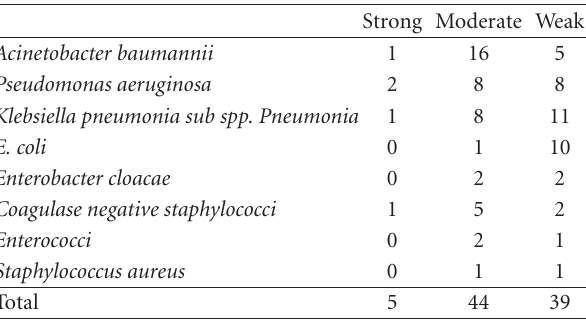
Table 2: Quantitative analysis of biofilm production by clinical bacterial isolates as evaluated by microtitre plate